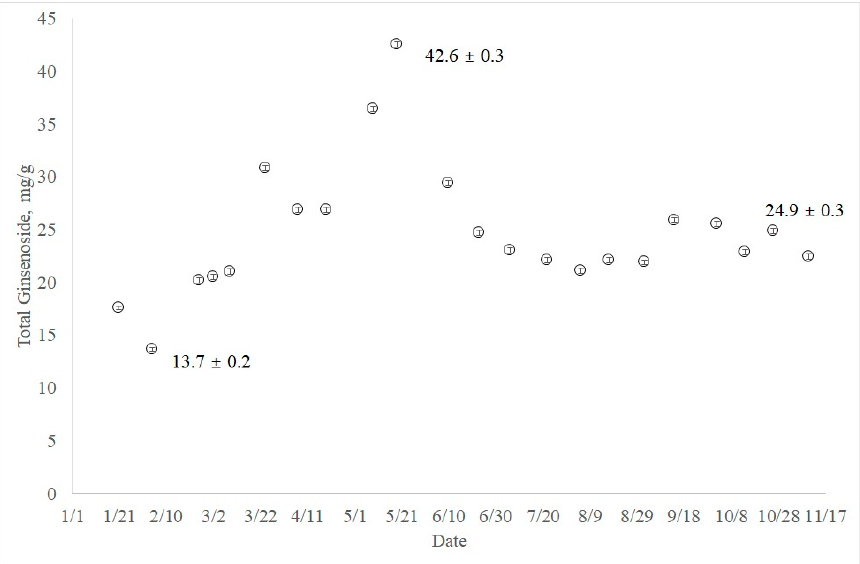
Figure 2. Total ginsenoside changes of five-year-old ginseng throughout the year.